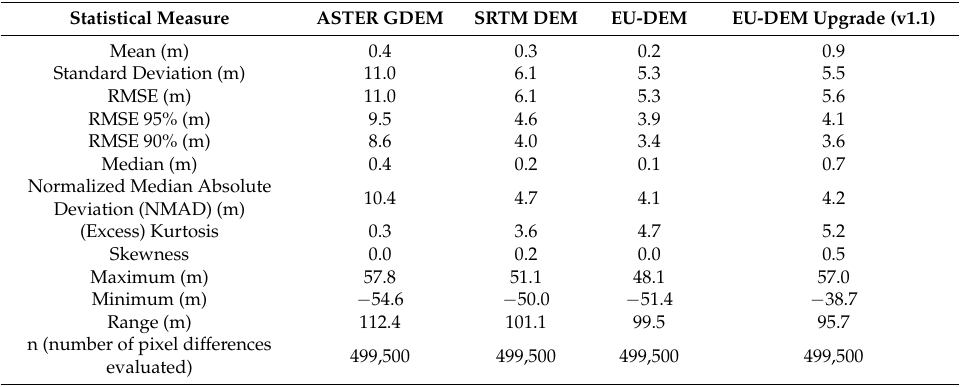
Figure 7. Histogram of relative elevation errors for the EU-DEM upgrade (v1.1). Table 2. Relative elevation errors: descriptive and other statistics for the three DEMs under evaluation. EU-DEM performed considerably better in most of the statistical parameters evaluated.